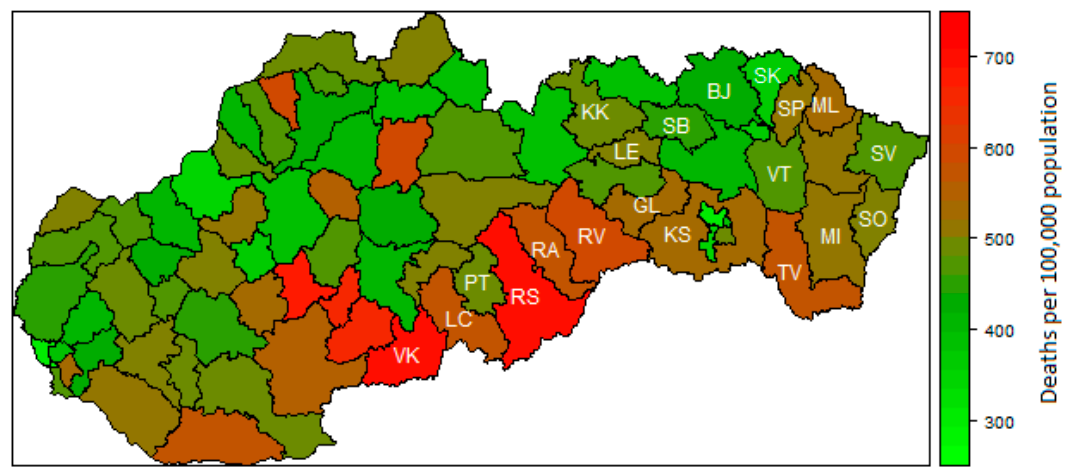
Figure 1. Preventable mortality of men in 2015. Note: Lu č enec district (LC), Poltár district (PT), Revúca district (RA), Rimavská Sobota district (RS), Ve ľ ký Krtíš district (VK), Kežmarok district (KK), Sabinov dsitrict (SB), Svidník district (SK), Vranov nad Top ľ ou district (VT), Gelnica district (GL), Rož ň ava district (RV), Sobrance district (SO), Trebišov district (TV), Bardejov district (BJ), Medzilaborce district (ML), Košice–okolie district (KS), Levo č a district (LE), Snina district (SV), Stropkov district (SP), and Michalovce district (MI).